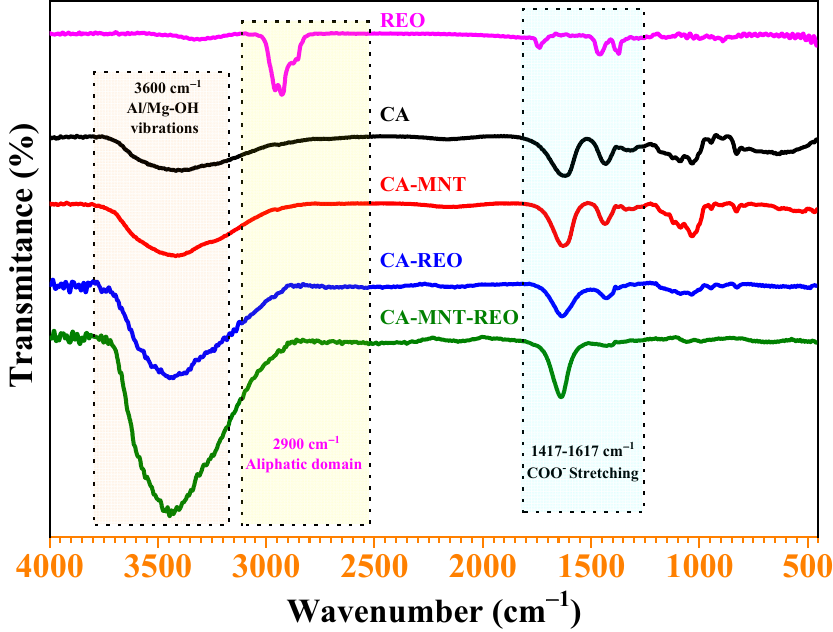
Figure 2. ATR-FTIR spectral of rosemary essential oil (REO), calcium alginate (CA), calcium alginate-montmorillonite (CA-MTN), calcium alginate-rosemary essential oil (CA-REO), and calcium alginate-montmorillonite-rosemary essential oil (CA-MTN-REO).